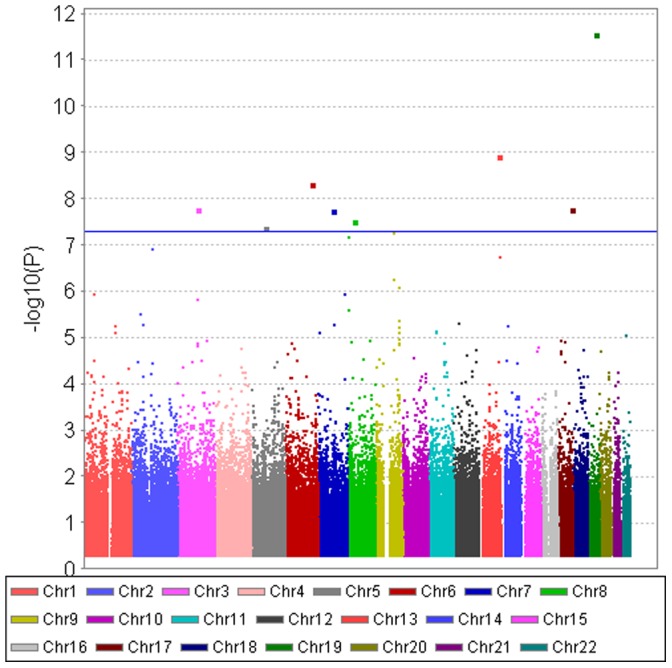
FHS data – the significance tests of SNP-specific correlations: the within-pair correlation of married couples against randomly-paired pairs.The tests for the 287,294 SNPs are shown in a Manhattan plot. The larger dots representing individual SNPs above the blue line indicate statistical significance at p<5×10−8.